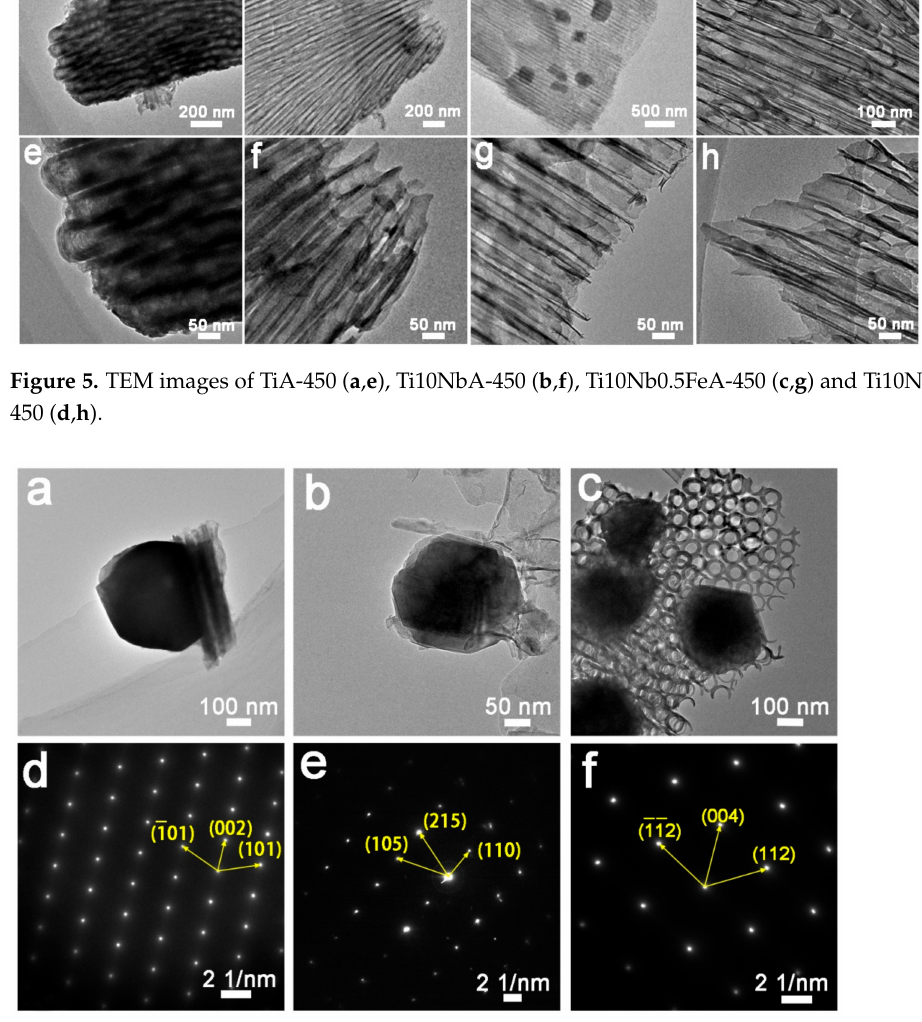
Figure 6. TEM and corresponding SAED images of different nanoparticles for Ti10NbA-450 ( a , d ), Ti10Nb0.5FeA-450 ( b , e ) and Ti10Nb1FeA-450 ( c , f